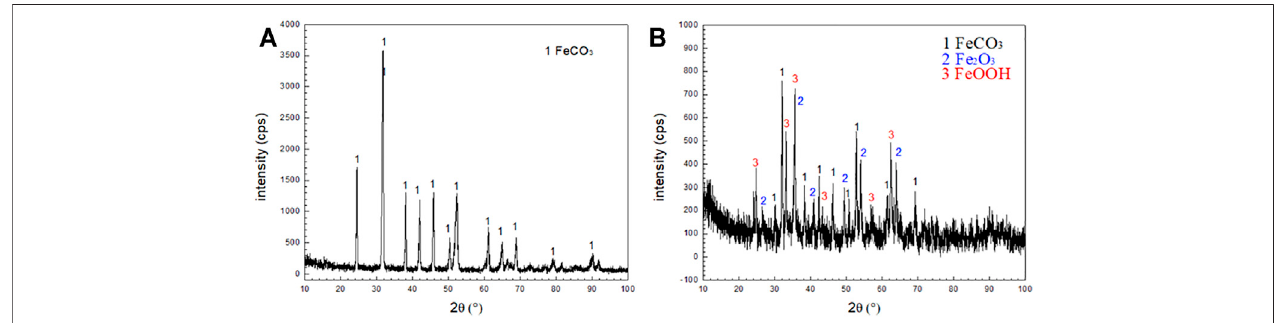
FIGURE 6 | XRD patterns of corrosion scale on N80 steel under CO 2 and CO 2 -O 2 conditions: (A) CO 2 − 2.5 MPa; (B) CO 2 − 2.5 MPa,O 2 − 0.5 MPa.